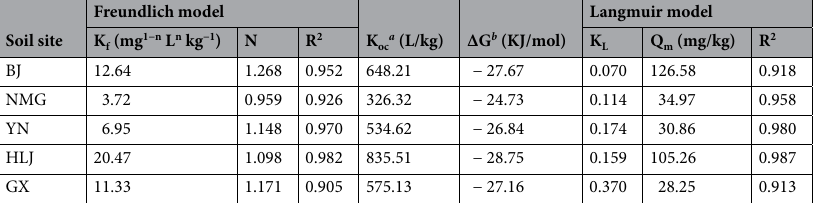
Table 2. Adsorption isotherm constants and characteristics derived from Freundlich and Langmuir equations for QUN in the five types of soil. K oc a = 100 K f /TOC (%). ΔG b =—1.724RTlnKoc.